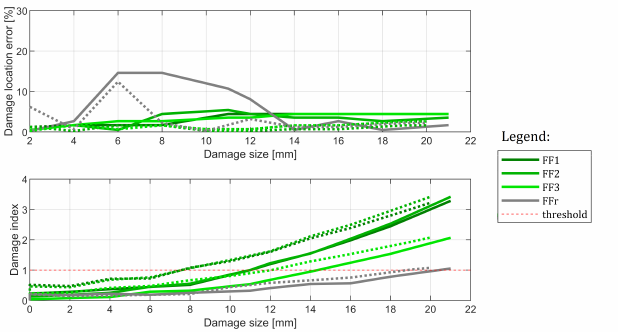
Figure 19. The results obtained for cases C#3 and C#5, that is for the same camera and damage location, but for two different specimens. Results from specimen 2 are marked in dashed